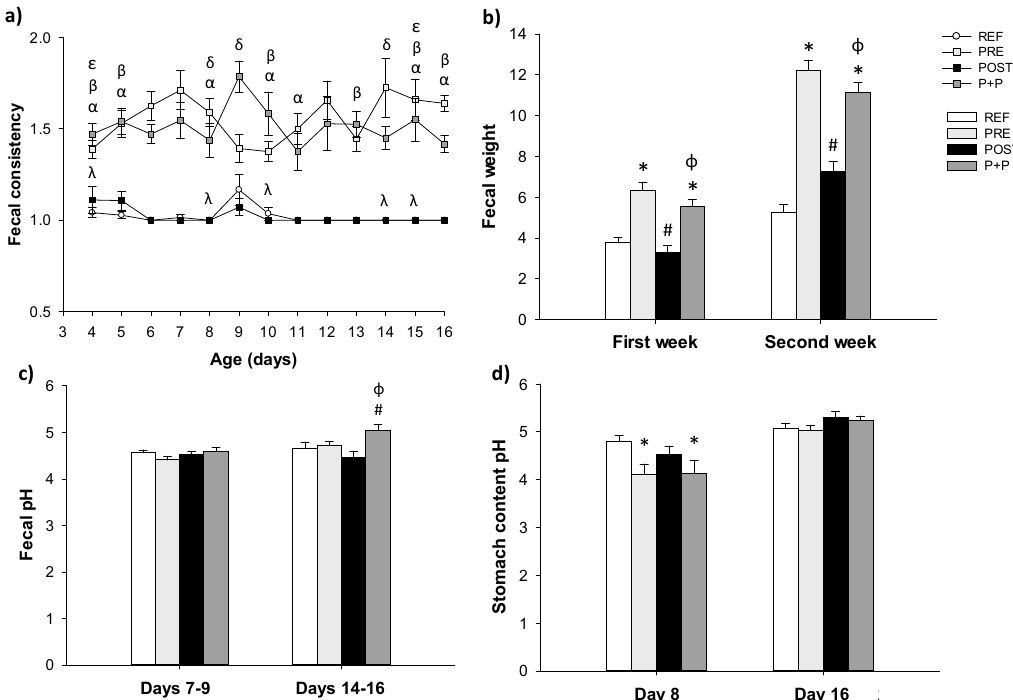
Figure 2. Fecal consistency during the study (from day 4 to day 16 of life) ( a ) and mean fecal weight from day 4 to day 7 (first week) and from day 8 to day 16 (second week) ( b ), fecal pH (on days 7–9 and 14–16) ( c ), and stomach content pH (on day 8 and 16) ( d ). Results are expressed as mean ± SEM (n = 12–24 animals/group). Statistical differences: α p < 0.05 PRE vs. REF, β P+P vs. REF, λ POST vs. PRE, δ P+P vs. PRE and ε P+P vs. POST ( a ), * vs. REF, # vs. PRE and φ vs. POST ( b – d ). REF: reference group; PRE: group supplemented with a mixture of scGOS and lcFOS; POST: group supplemented with Lactofidus TM ; P+P: group supplemented with the combination of